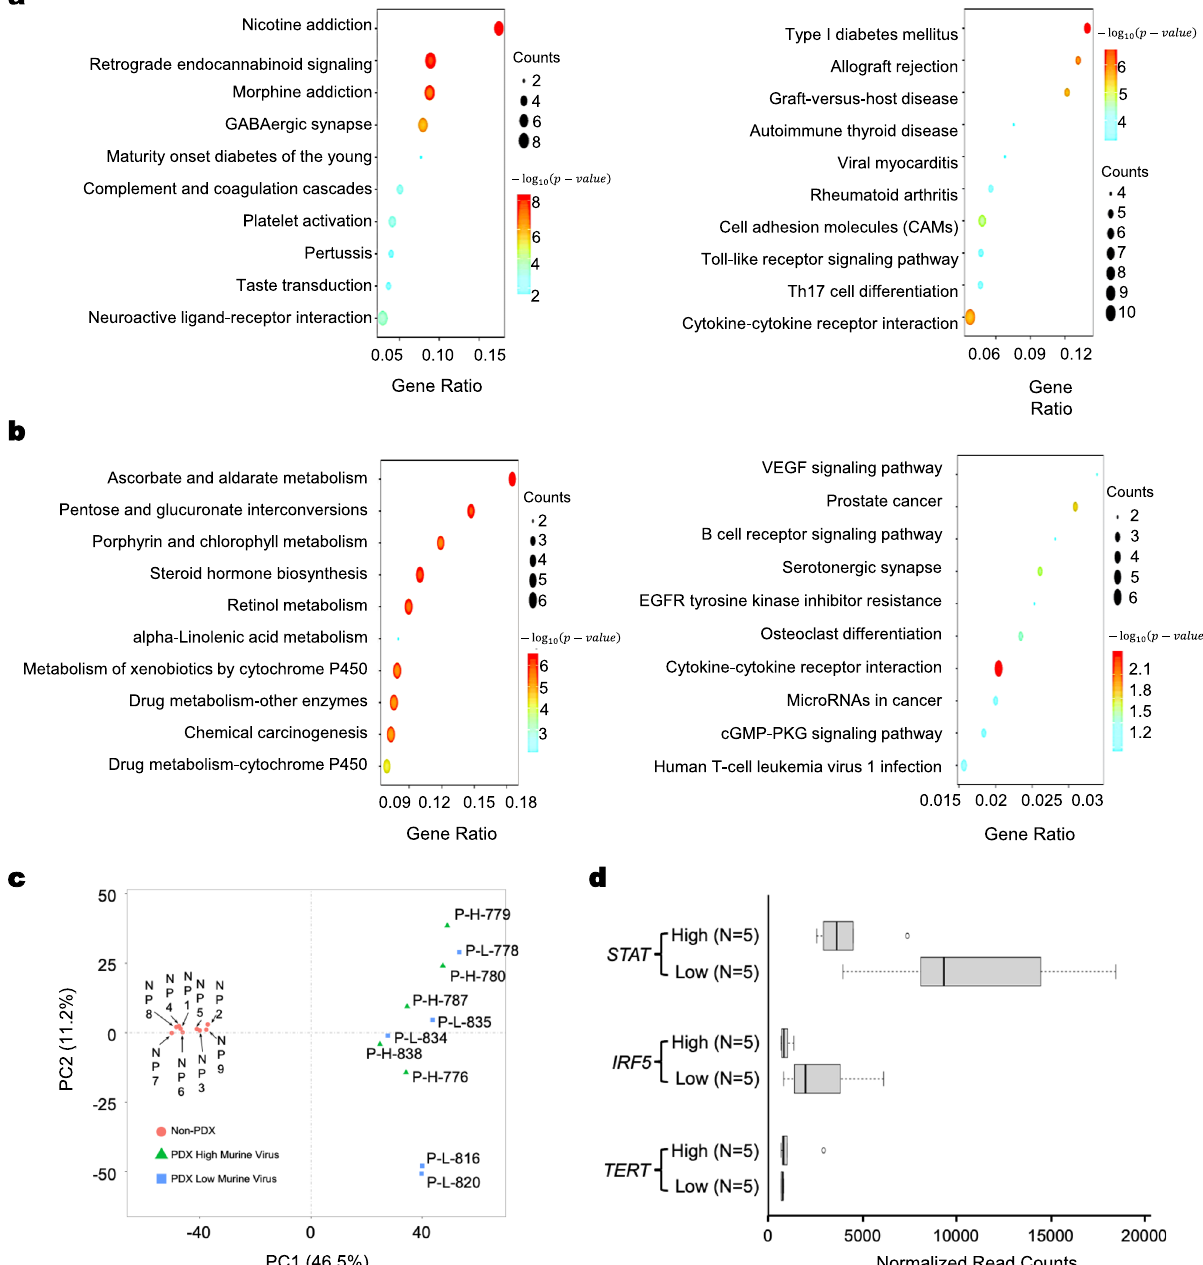
Fig. 5 Impact of murine viral infection on gene expression in PDX tumors. Transcription pro fi les of lung cancer PDX samples with highest and lowest viral numbers. Pathways and functions were enriched among: a the top 200 upregulated (left) and downregulated genes (right) in the 5 PDX samples with the most murine viral infection. b Transcription pro fi les of pictilisib-treated bladder cancer PDX samples with highest and lowest viral numbers. Pathways and functions were enriched among the top 200 upregulated (left) and downregulated (right) genes in the samples with the most murine viral infection. c Primary tumors before creation of PDX models have consistent gene expression pro fi les and form a major component in principal components analysis, compared to PDX tumors with viral infection and very diverse transcription pro fi les. d Three genes ( STAT , IRF5, and TERT ) differentially expressed between PDX tumors with highest (High, n = 5) and lowest (Low, n = 5) levels of murine viruses. There genes are also differentially expressed in oncolytic virus- infected lung cancer. Box limits: 25th and 75th percentiles; center line: median; whiskers: 1.5x interquantile range from box limits; dots: outliers. Source data for ( a , b , and d ) are provided in the Source Data File. Datasets used to create c are listed in Supplementary Table